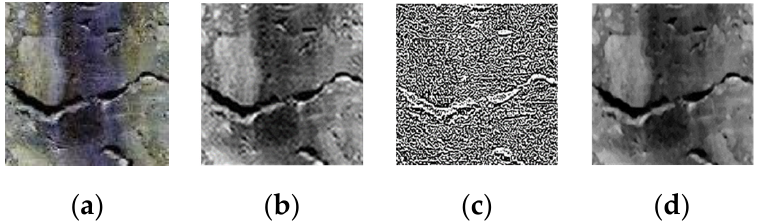
Figure 4. The effect of three kinds of filtering methods. ( a ) shows the original dam crack image. ( b ) shows the effect under low-pass filtering. ( c ) shows the effect under high-pass filtering. ( d ) shows the effect under our improved